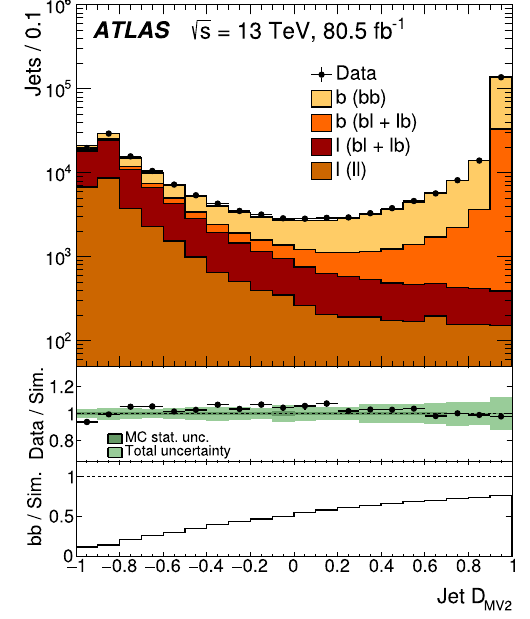
Fig. 4 Distribution of the output discriminant of the MV2 algorithm for the jets in events passing the selection. Simulated events are clas- sified according to the flavour composition of the two jets, where the first term in each legend entry represents the flavour of the jet which is plotted ( b or l ) and the following term in parenthesis represents the flavour composition of the event ( bb , bl + lb or ll ). The ratio panels show the data-to-simulation ratio as well as the fraction of bb events among the simulated